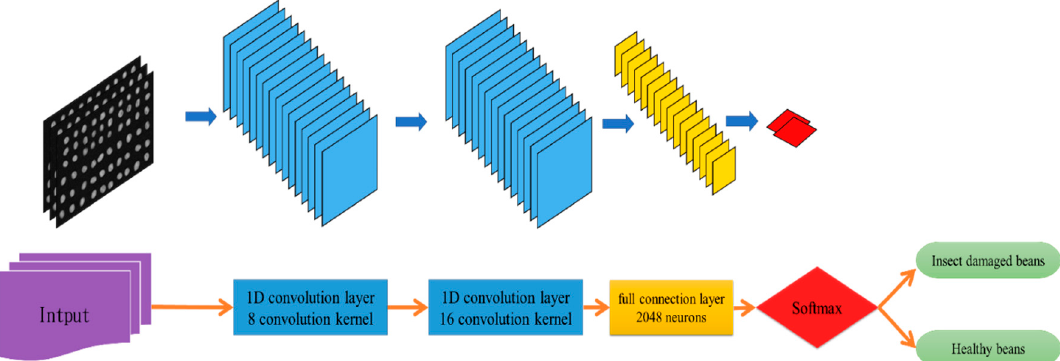
Figure 8. The 1D-CNN model architecture.